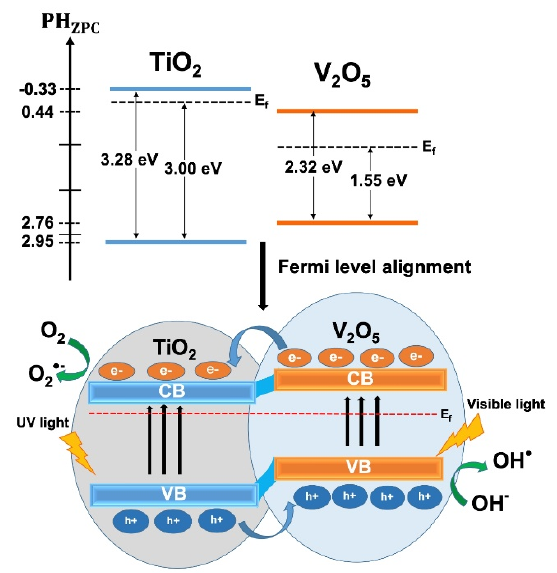
Figure 7. Possible mechanisms for photo-catalysis over the nanoheterostructure films.